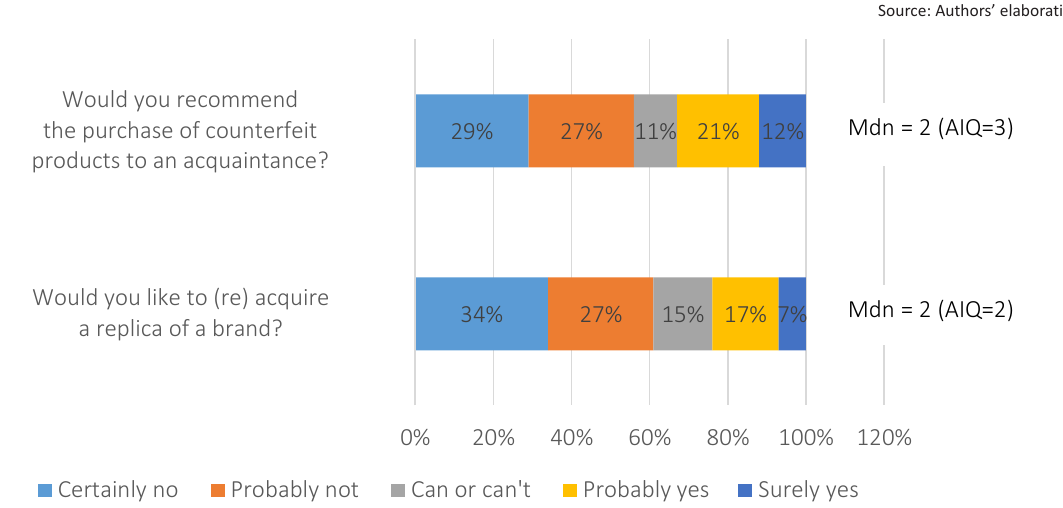
Figure 2. Intention to re-acquire or recommend counterfeit